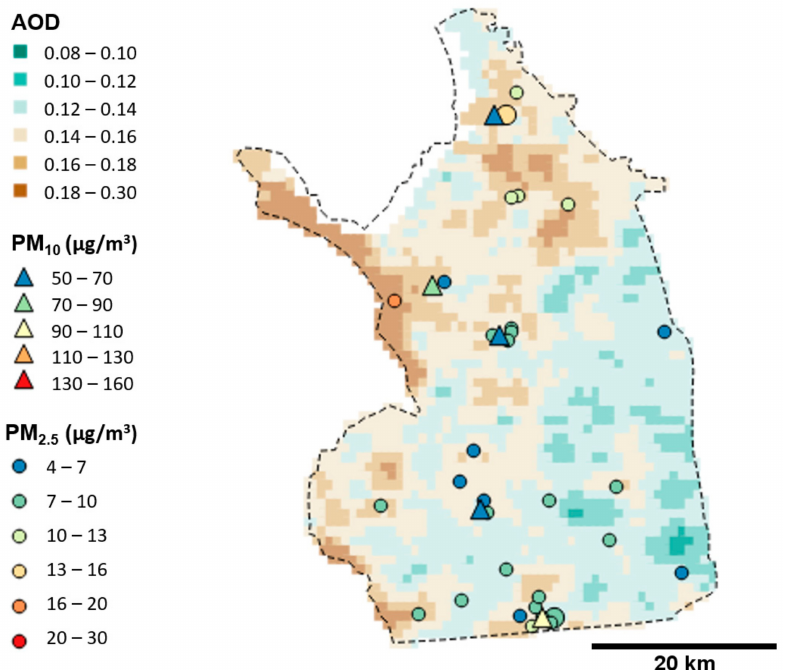
Figure 9. As in Figure 8, but for the WSW set during 2017 ( n = 7 days, see Table 2).